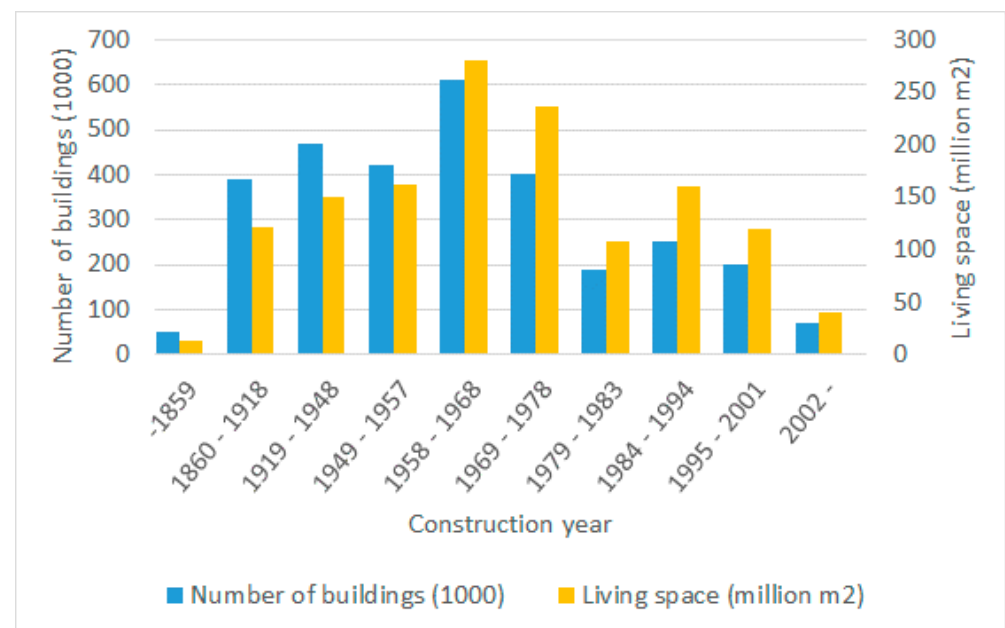
Figure 3. The German apartment buildings based on the construction year (data retrieved from [29]). Table 5. Average U-values in German residential buildings (W / m 2 K) (data retrieved from [29]). Construction Year Wall Roof Floor Window until 1978